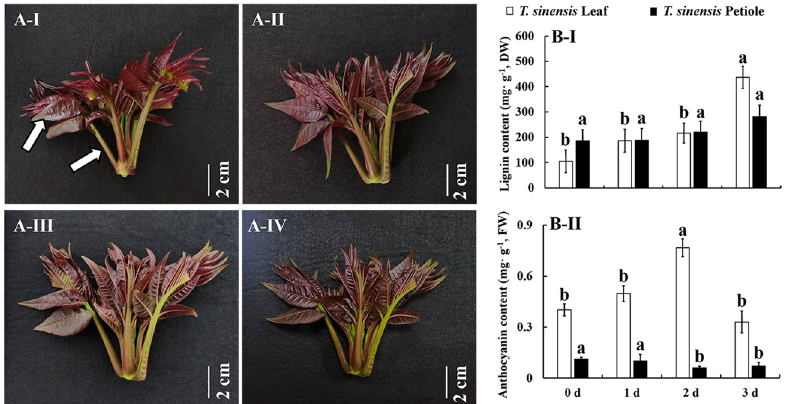
Figure 1. Color changes and anthocyanins, lignin and chlorophyll content of red T. sinensis buds during storage. ( A-I ): Stored red T. sinensis buds for 0 d; ( A-II ): Stored red T. sinensis buds for 1 d; ( A-III ): Stored red T. sinensis buds for 2 d; ( A-IV ): Stored red T. sinensis buds for 3 d; ( B-I ): Lignin content of red T. sinensis buds during storage; ( B-II ): Anthocyanin content of red T. sinensis buds during storage. Note: The white arrows in the figure represent the sampling site for observing the paraffin section. Different lowercase letters on the column indicates significant differences among different treatments ( p <